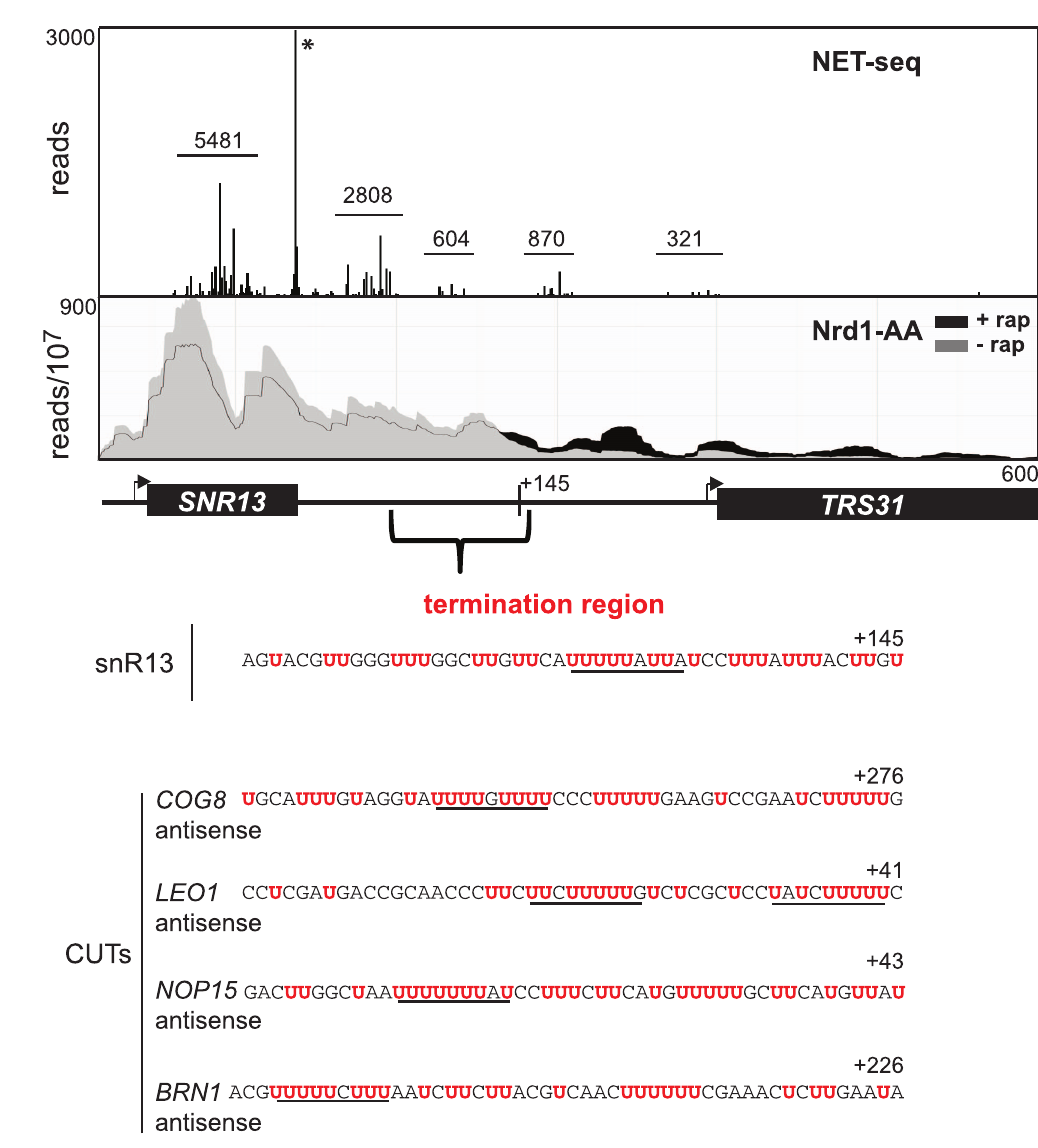
Figure 4. SNR13 termination region. NET-Seq data from Churchman and Weissman [53] are shown above PAR-CLIP data from the SNR13-TRS31 locus. The number of NET-seq reads from peaks of Pol II are shown above the lines. The asterisk indicates reads derived from mature snR13 RNA that contaminates the NET-seq library. The calculated SNR13 termination region has been expanded to show U-rich sequences (red) surrounding the termination point. The sequences of several antisense CUT termination regions are shown below the SNR13